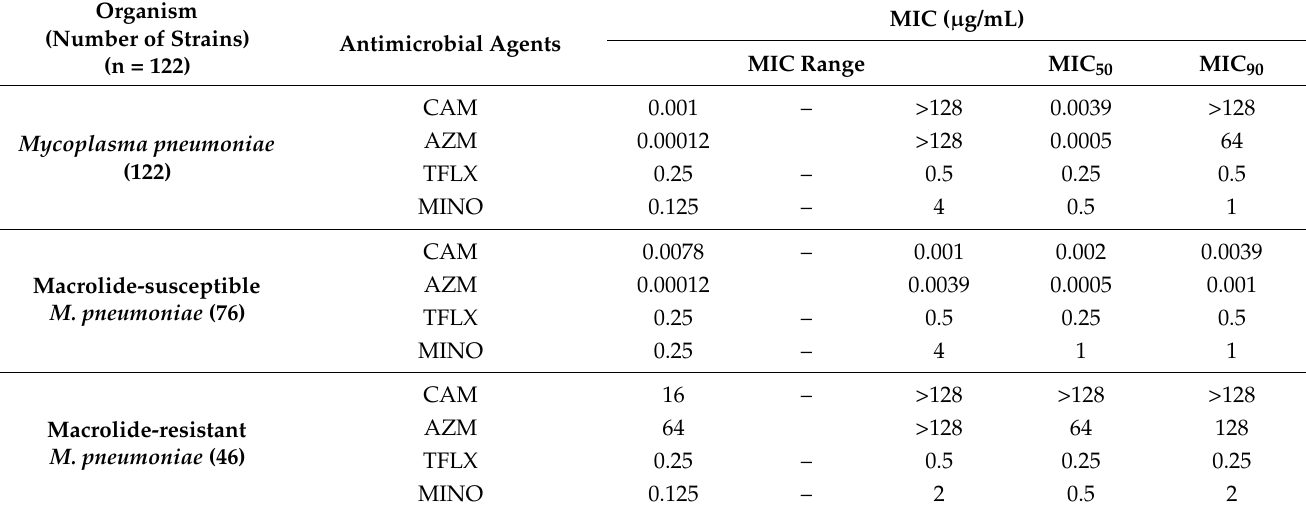
Table 1. In vitro antimicrobial activity against clinical isolates of Mycoplasma pneumoniae strains from 2017 to 2020. Antimicrobial susceptibility testing was performed as reported in